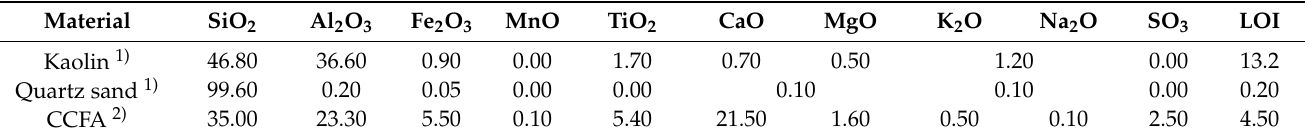
Table 1. Chemical composition (wt. %) of all used